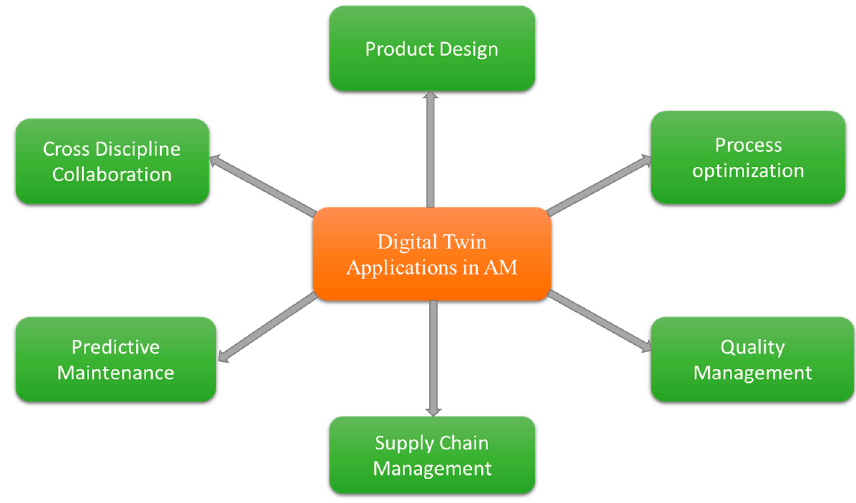
Figure 7. Digital twin applications in AM.